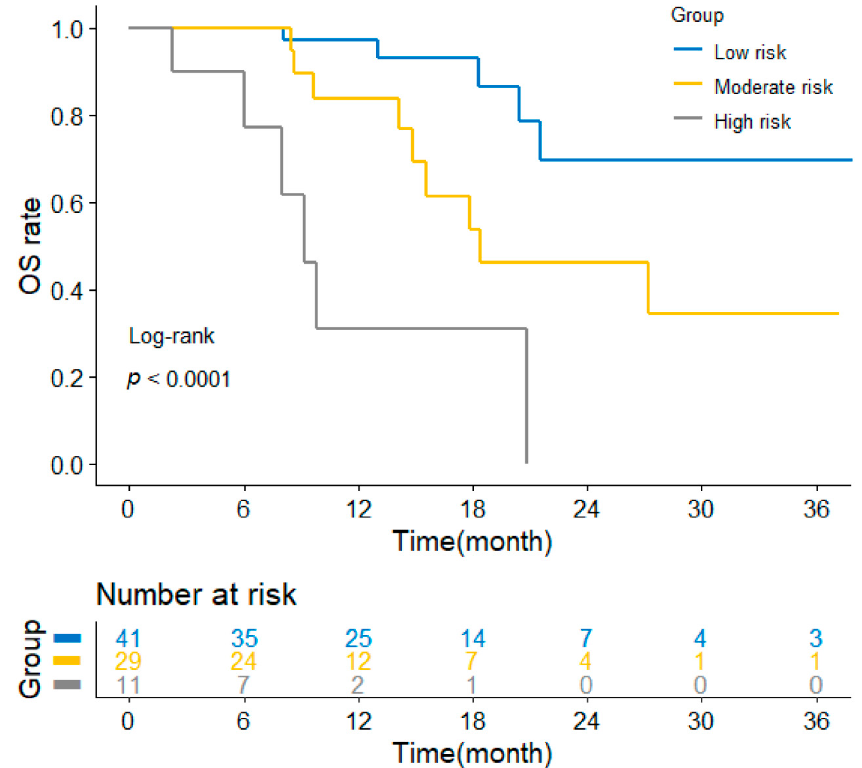
Figure 5. Kaplan–Meier curves of OS for ESCC patients in low-, moderate-, and high-risk groups stratified by the nomogram-generated scores. Abbreviations: OS, overall survival; ESCC, esophageal squamous cell carcinoma.